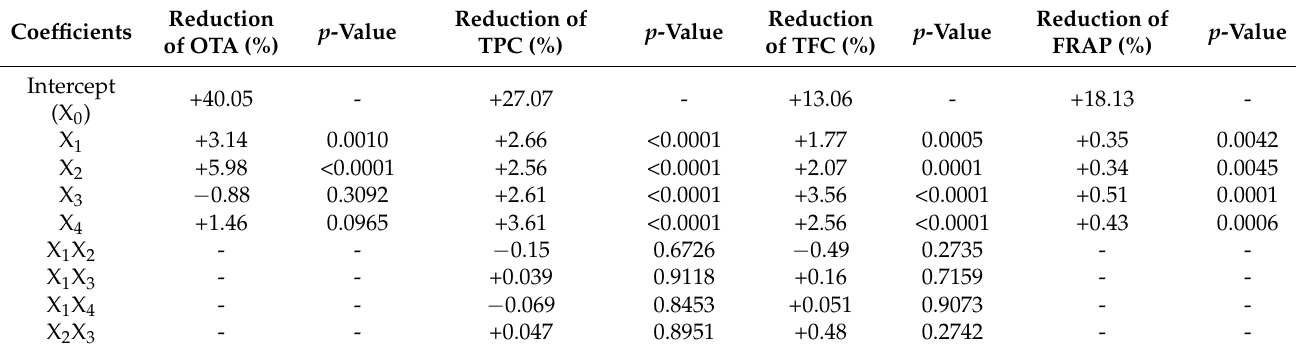
Table 4. Regression coefficients of coded factors for the responses during the optimization of grape juice